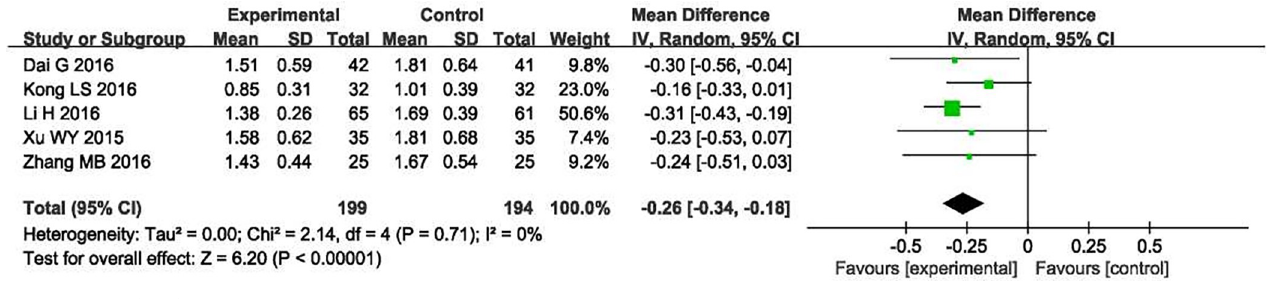
Fig 12. Forest plot of cystatin